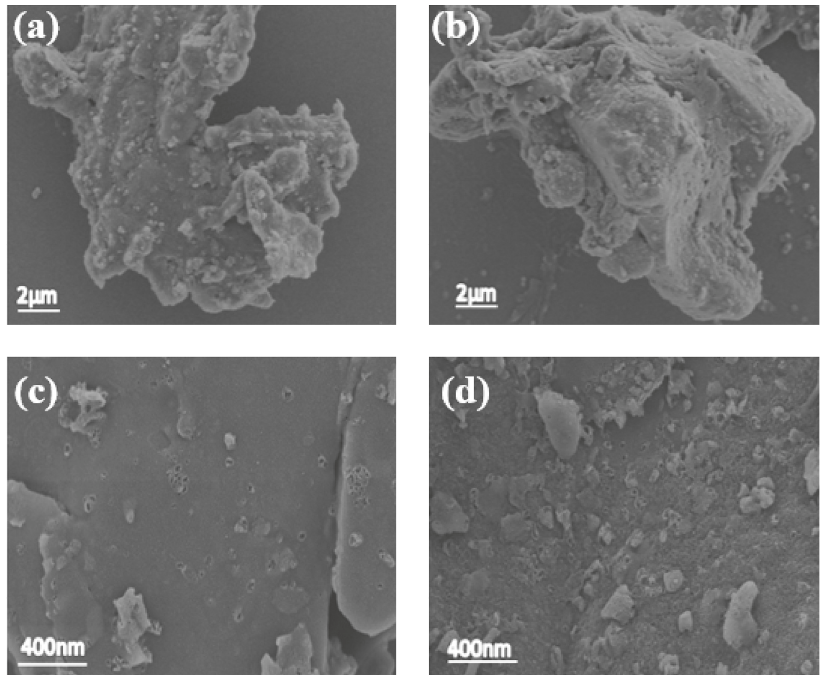
Figure 2: SEM images of RC (a) and PRC (b); SEM images of DRC (c) and DPRC (d).